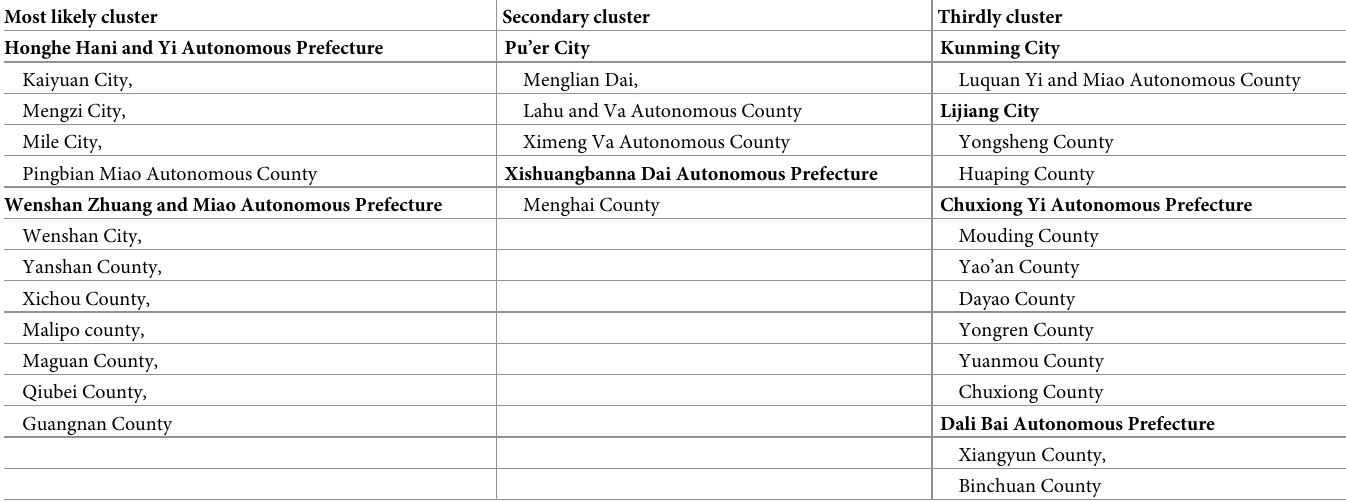
Table 6. The identified significant high-rate spatial-temporal clusters of new detected leprosy cases in Yunnan, China, 2011–2020. Most likely